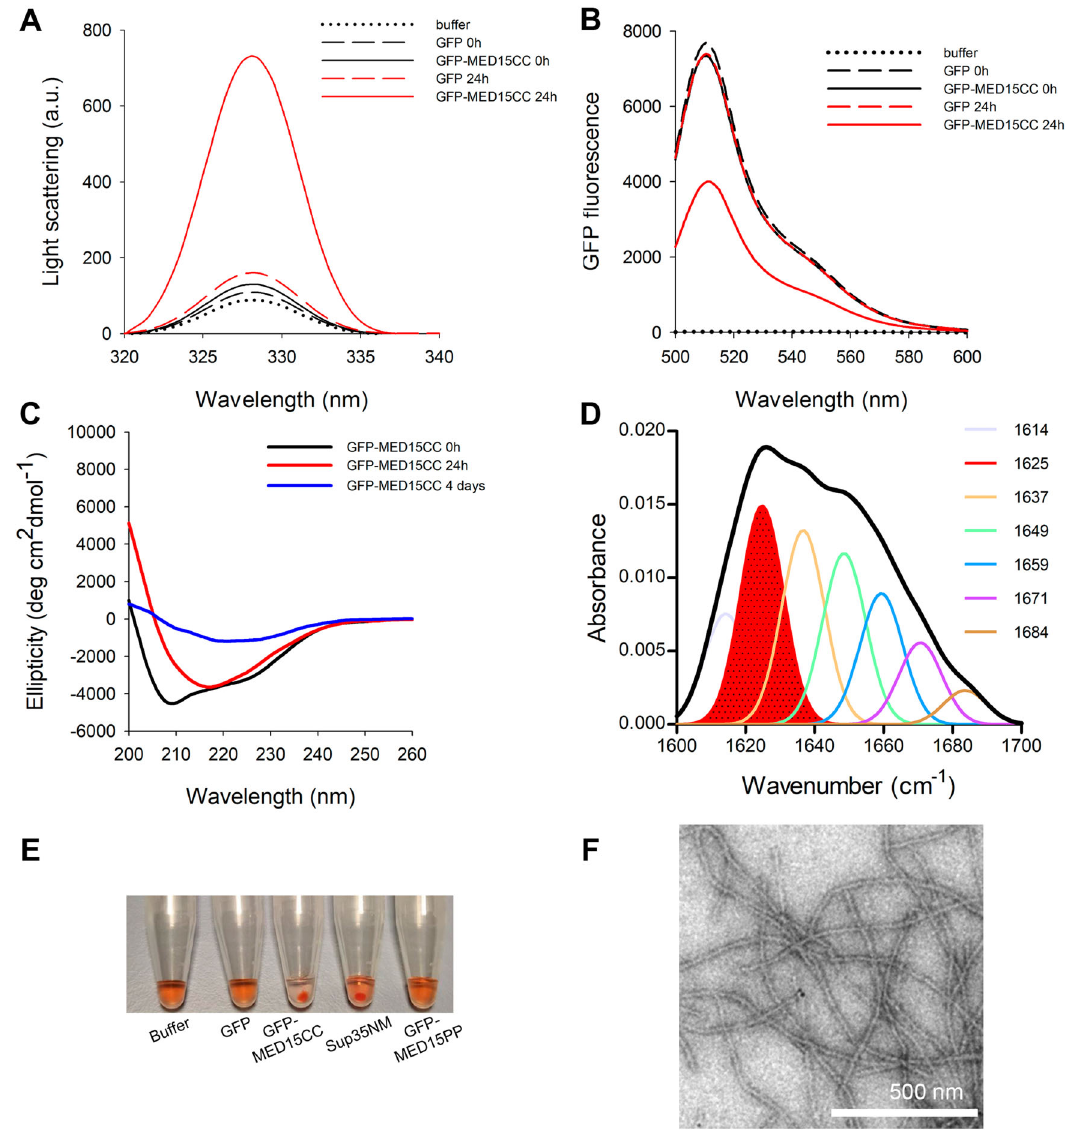
Fig. 3 MED15-PrLD aggregates into β -sheet enriched amyloid-like fi brillar structures. A Light scattering, B GFP fl uorescence (supernatant fraction) and C circular dichroism of soluble ( t = 0h, black) and aggregated ( t = 24h, red, or t = 4 days, blue) 5 μ M GFP-MED15CC or GFP. D FTIR of aggregated ( t = 24h) 5 μ M GFP-MED15CC. E Congo Red precipitation of incubated ( t = 9h) 5 μ M GFP, GFP-MED15CC, GFP-MED15PP, and 10 μ M Sup35NM. F Transmission electron microscopy image of aggregated ( t = 9h) 5 μ M GFP-MED15CC. All assays are performed in 20mM Tris pH 7.5 and 150mM